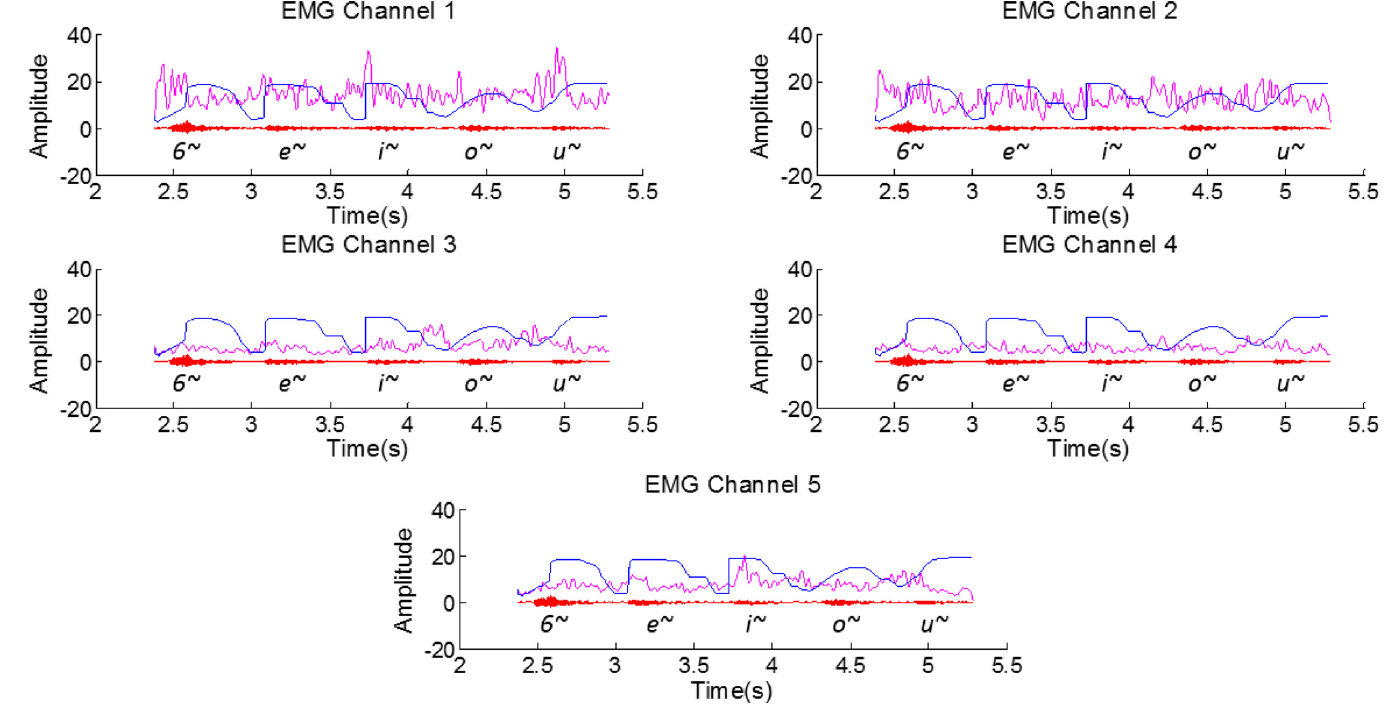
Fig 10. Portuguese vowels in an isolated context (Pre-processed EMG signal for all EMG channels (pink), the aligned RT-MRI information (blue) and the respective audio signal (red) for [6~, e~, i~, o~, u~]). An amplitude gain was applied to the RT-MRI information and to the EMG for better visualization of the superimposed